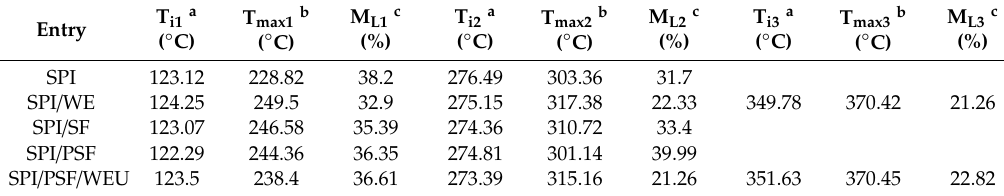
Figure 6. Thermogravimetric (TG) and derivative thermogravimetric (DTG) curves of neat SPI, SPI/WEU, SPI/SF, SPI/PSF, and SPI/PSF/WEU films. Table 3. Thermo-degradation data of SPI-based films under N 2 atmosphere.